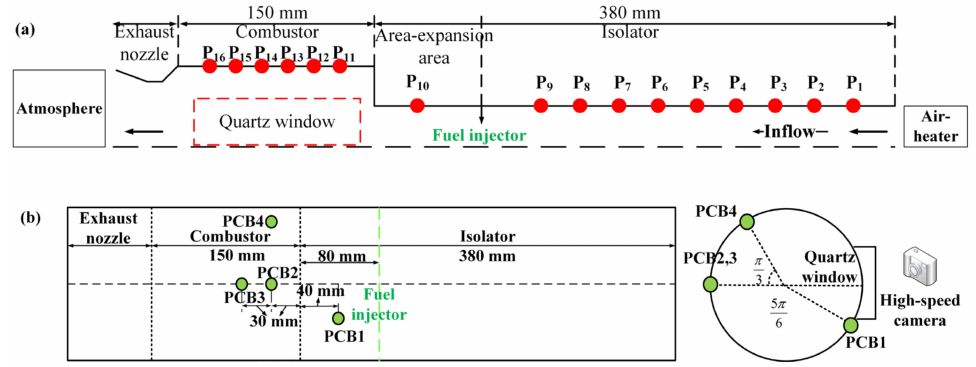
Figure 1. Schematic view of the cylindrical isolator and combustor engine: ( a ) Maxwell pressure transducers installation locations; ( b ) PCB sensor installation